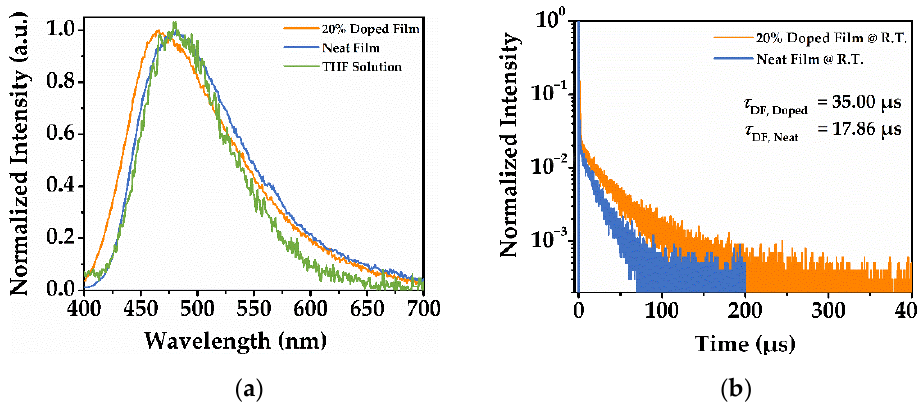
Figure 3. ( a ) The photoluminescence spectra; ( b ) the transient decay curve of PDPC film.